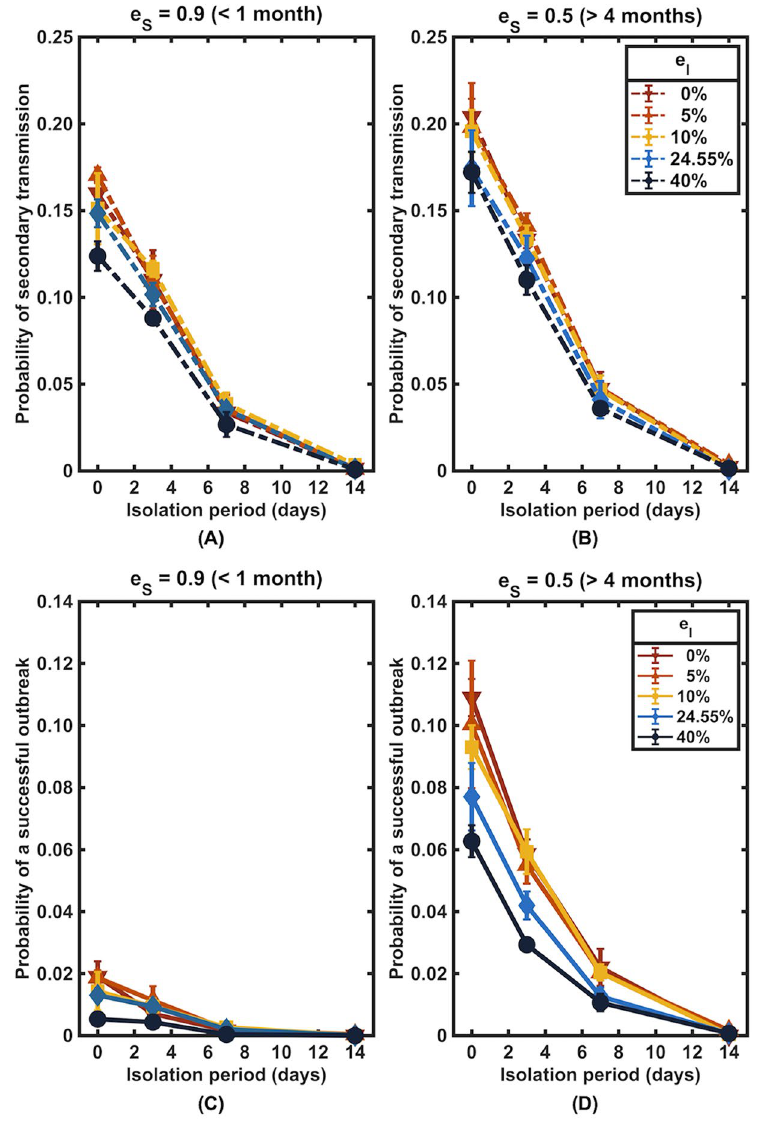
Figure 5. The influence of vaccine effectiveness against SARS-CoV-2 transmission. The probability of at least one secondary infection ( A and B) and a successful outbreak ( C and D ) after being released from isolation into a community with a vaccination level of 75%. The vaccine effectiveness against transmission (e I ) varied from 0 to 40%, and the vaccine effectiveness against infection (e S ) was fixed at 90% (left column) and 50% (right